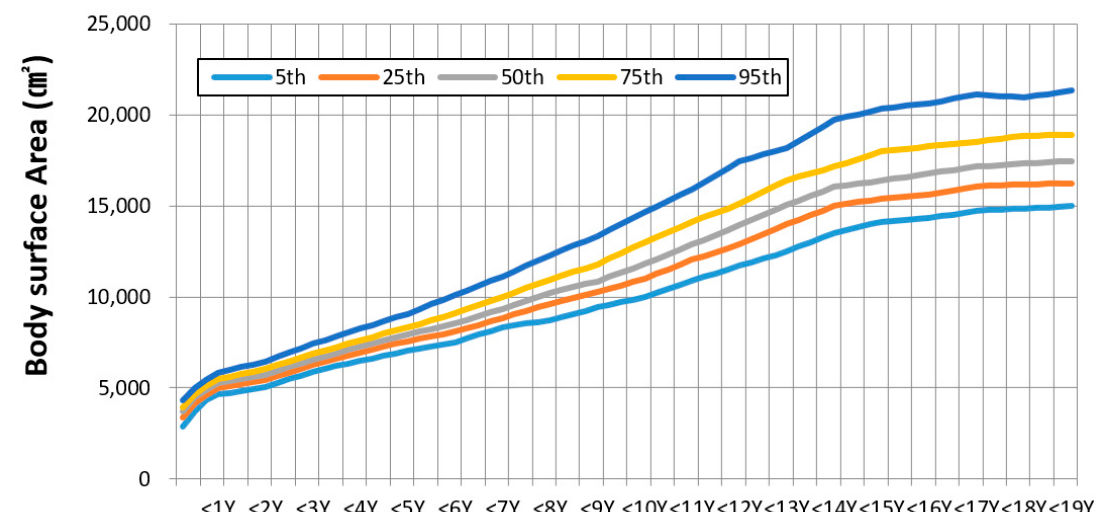
Figure 1. Estimation of body surface area based on body weight and height according to age.